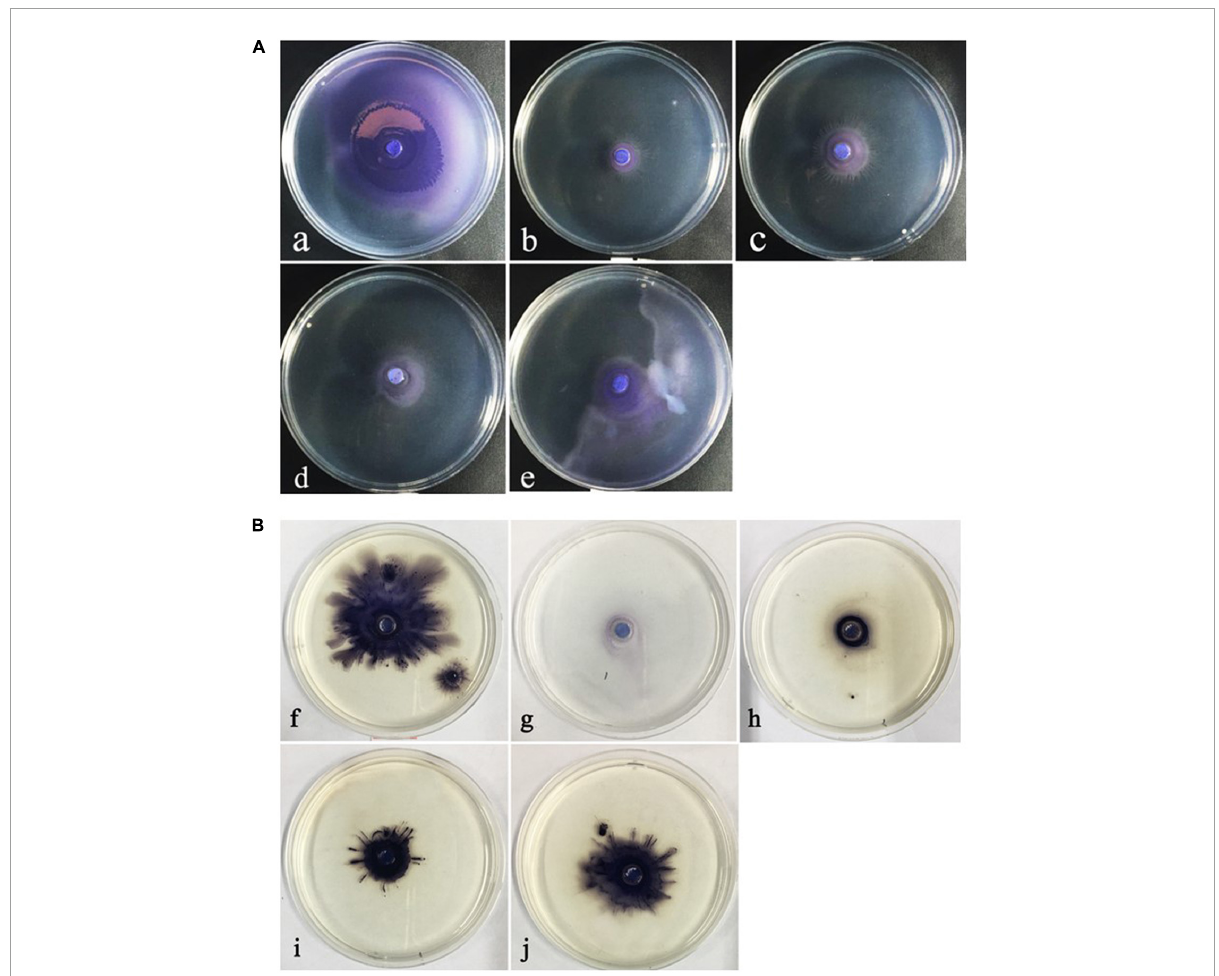
FIGURE4 The inhibitory of the motility behavior of Chomobacterium violaceum by methyleugenol (ME). (A) Swarming (a–e) , (B) Swimming (f–j) , (a,f) control, untreated with ME. (b–e,g–j) treated with the concentration of sub-MIC (5, 2.5, 1.25, and 0.625